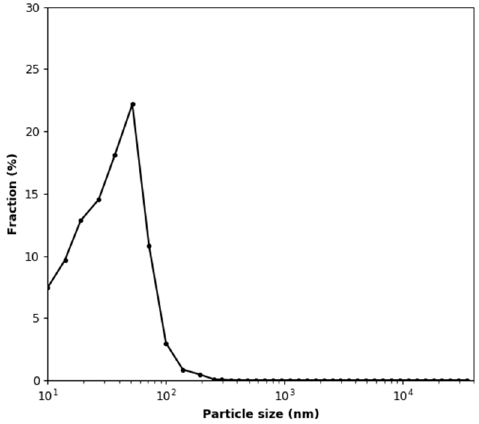
Figure 15. Test aerosol size distribution during the soot effect test under variable humidity condi- tions.